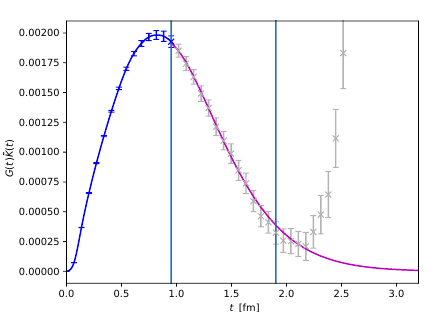
(b) Plot showing the full integrand of Equation 7. Blue crosses are the integrand data points used in constraining a cubic spline (blue curve). The magenta line in the tail is from our exponen- tial function fit for the t > t cut region, with the fit window indicated by the two vertical lines Greyed crosses are integrand points after t cut , which are replaced by the fitted